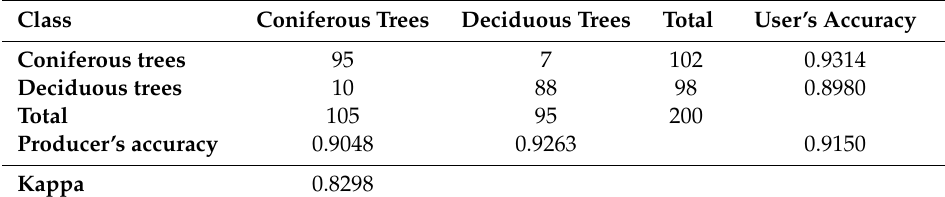
Table 3. Confusion matrix for NDVI-based classification.